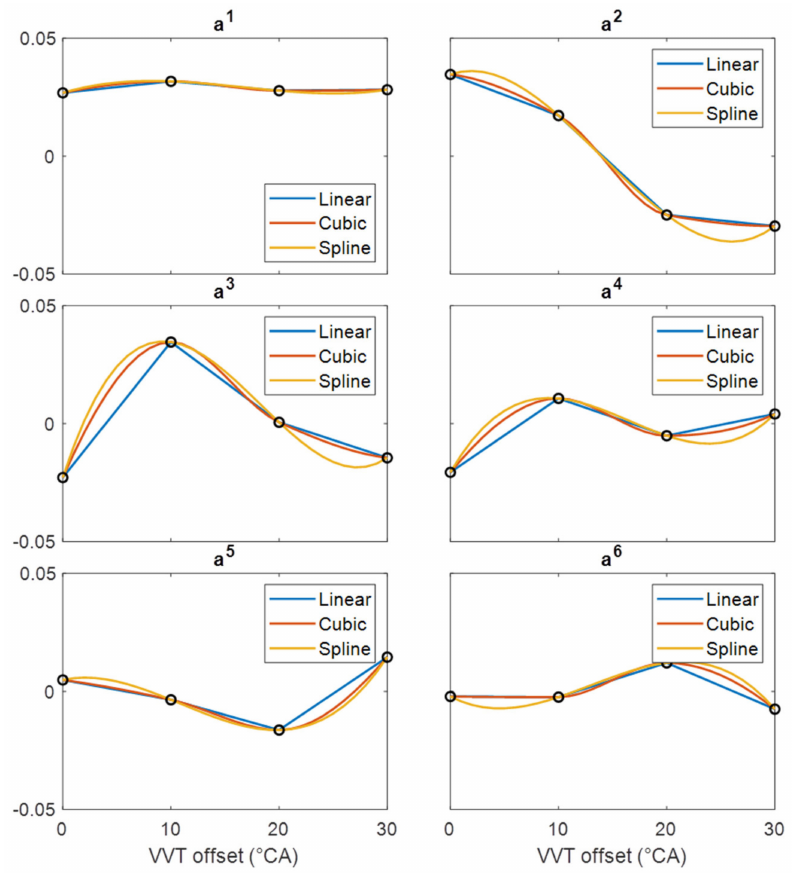
Figure 13. Interpolation of the average POD coefficients as a function of the VVT offset; POD: θ = 130 ◦ CA; θ VVT = { 0,10,20,30 } .